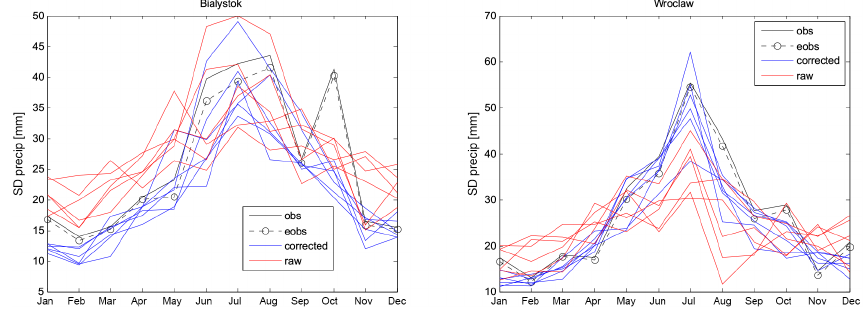
Figure 4. Comparison of standard deviation of monthly sum of precipitation calculated over the reference time period for two grid cells located close to Białystok (NE Poland) and Wrocław (SW Poland). The black continuous line denotes observations from meteorological stations, black dashed lines denote observations from the E-OBS reanalysis, red lines denote precipitation values from uncorrected RCMs, and blue lines denote bias corrected RCM precipitation